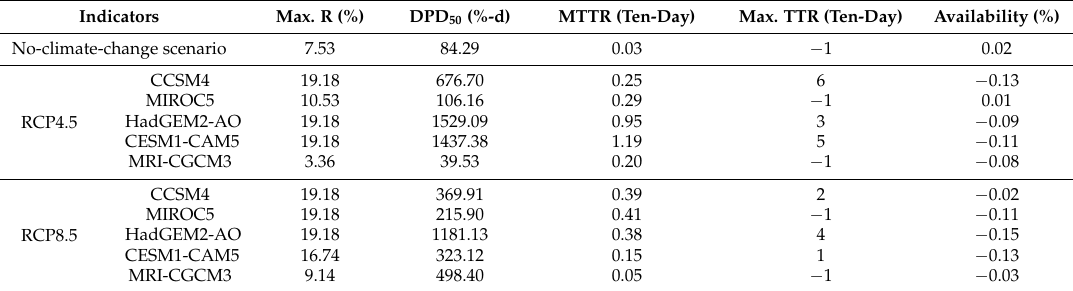
Table 6. Difference of risks of FPC water use under baseline and future